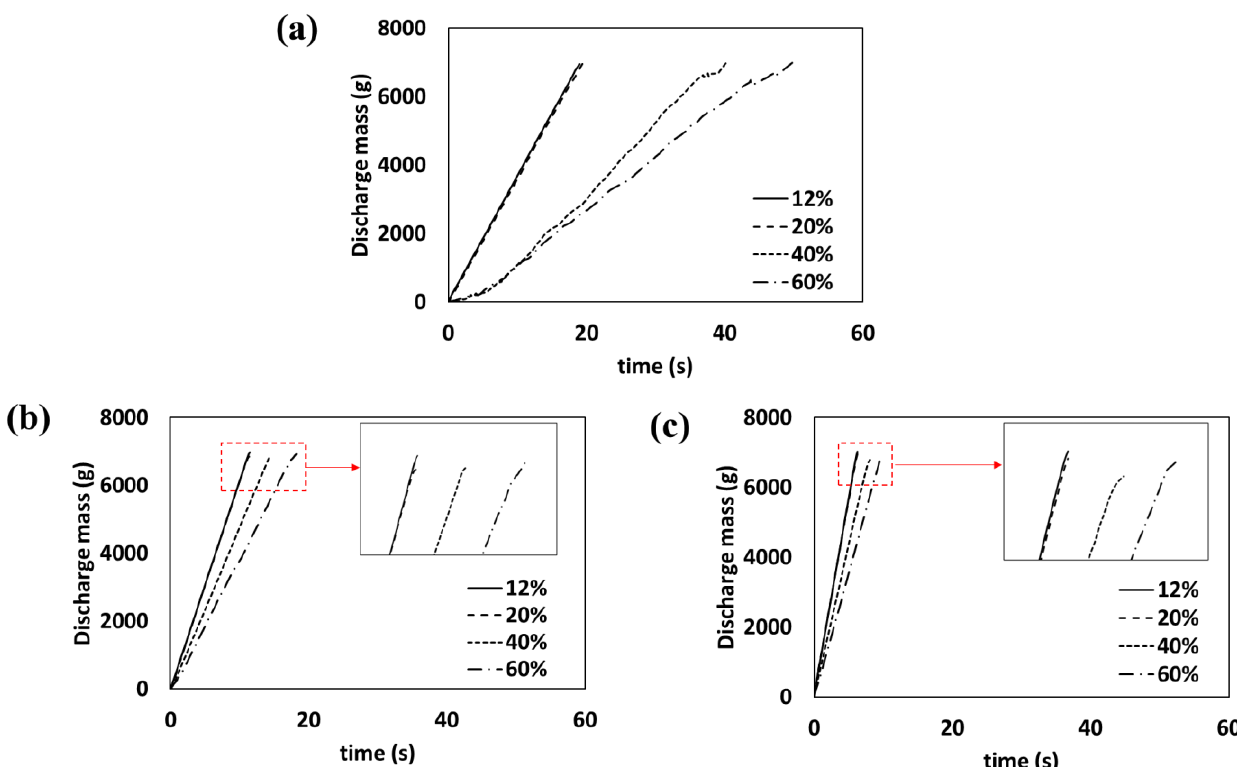
Figure 7. Mass profiles of soybeans with different moisture contents (12, 20, 40, and 60%) discharged through orifices of different sizes: ( a ) 40 mm, ( b ) 50 mm, and ( c) 60 mm. Insets are the expanded mass profiles.